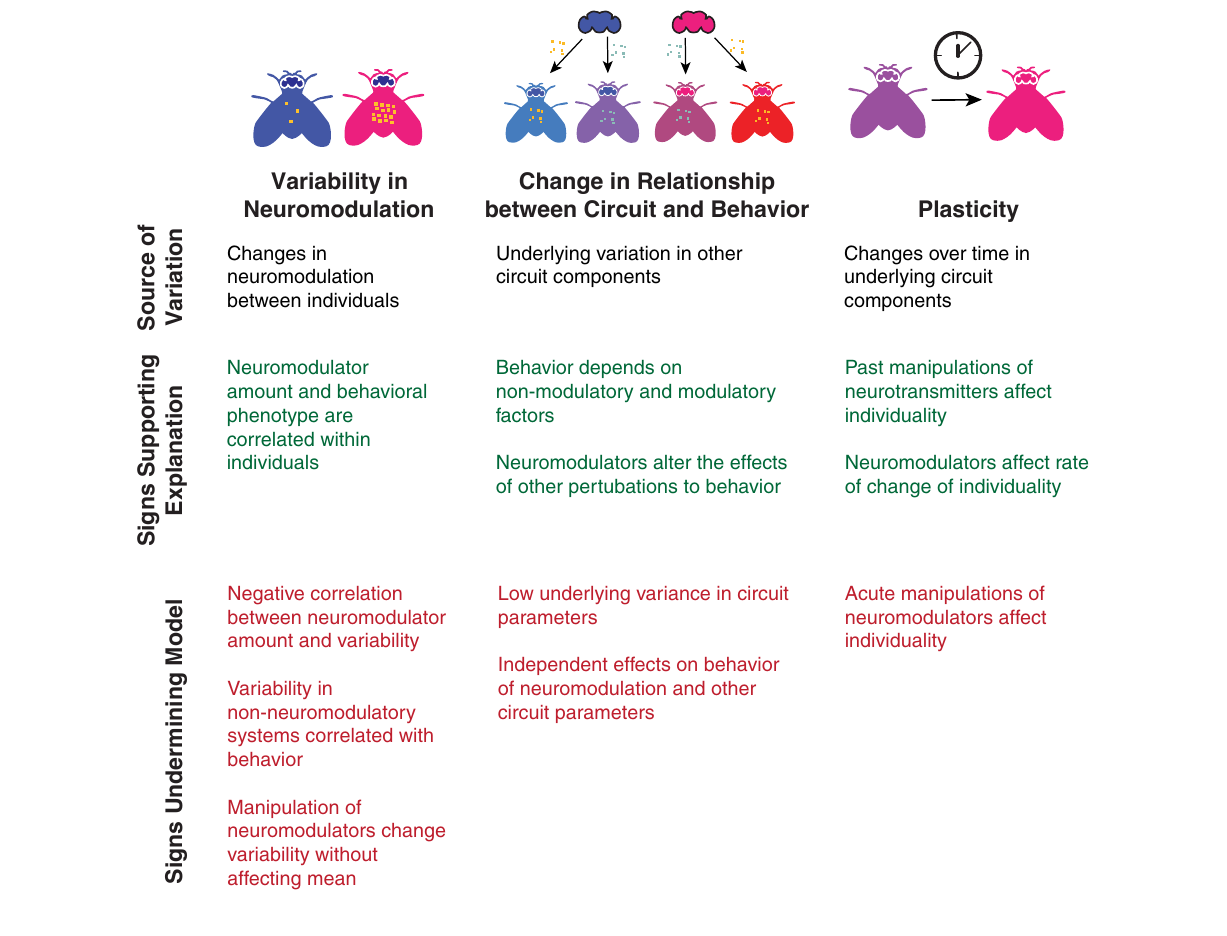
FIGURE 4 | Tests for differentiating between models of how neuromodulators affect individuality. Observations that provide evidence for each model are listed in green, and observations that are contraindicative for each model are shown in